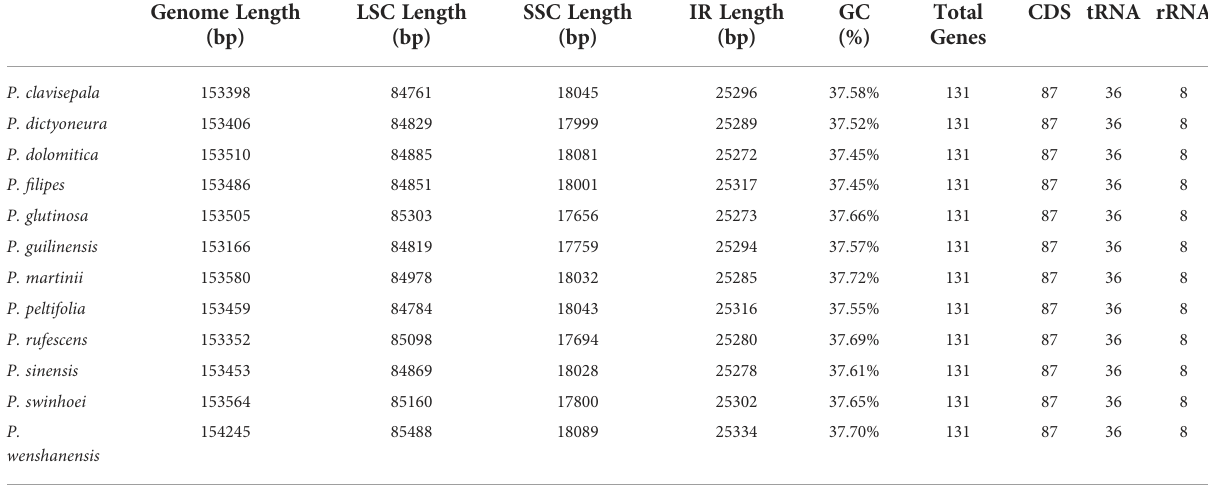
TABLE 2 Summary of the chloroplast genomes of twelve Paraboea species. Genome Length (bp)